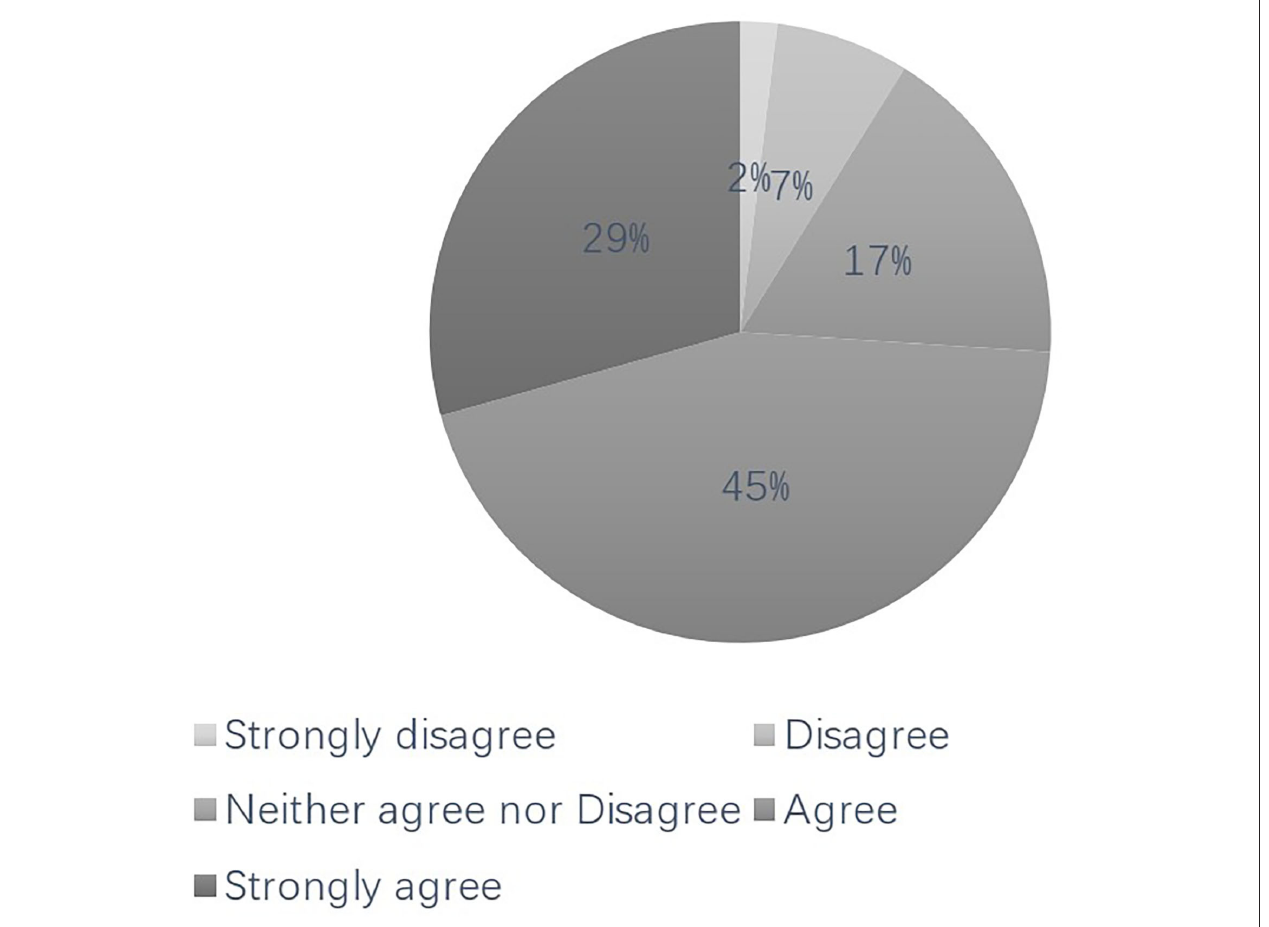
FIGURE 1 | Proportional distribution of respondents based on their trust in physician (%). The distribution of the respondents is clockwise organized from “strongly disagree” to “strongly agree”.